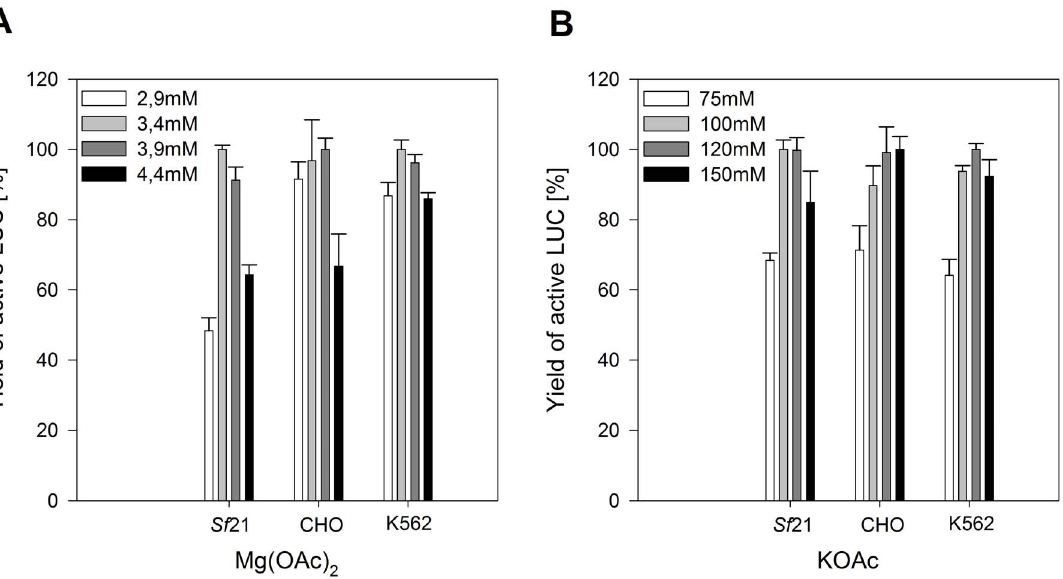
Figure 2. Evaluation of optimal Mg(OAc) 2 (A) and KOAc (B) concentration in coupled eukaryotic cell-free expression systems. De novo synthesized LUC was monitored after 3 h of incubation at 27 u C ( Sf 21 cell extract) and 33 u C (CHO and K562 cell extracts), respectively. Cell-free protein synthesis was performed using the optimized vector containing the CrPV IGR IRES harboring an AUG-to-GCU mutation of the initiation codon in the EasyXpress pIX3.0 vector backbone. Protein yields were normalized to the reaction with the highest yield of active LUC (=100%) for each cell- free system. Yields of active LUC were determined from three independent experiments using a LUC reporter assay and the corresponding standard deviations were calculated.